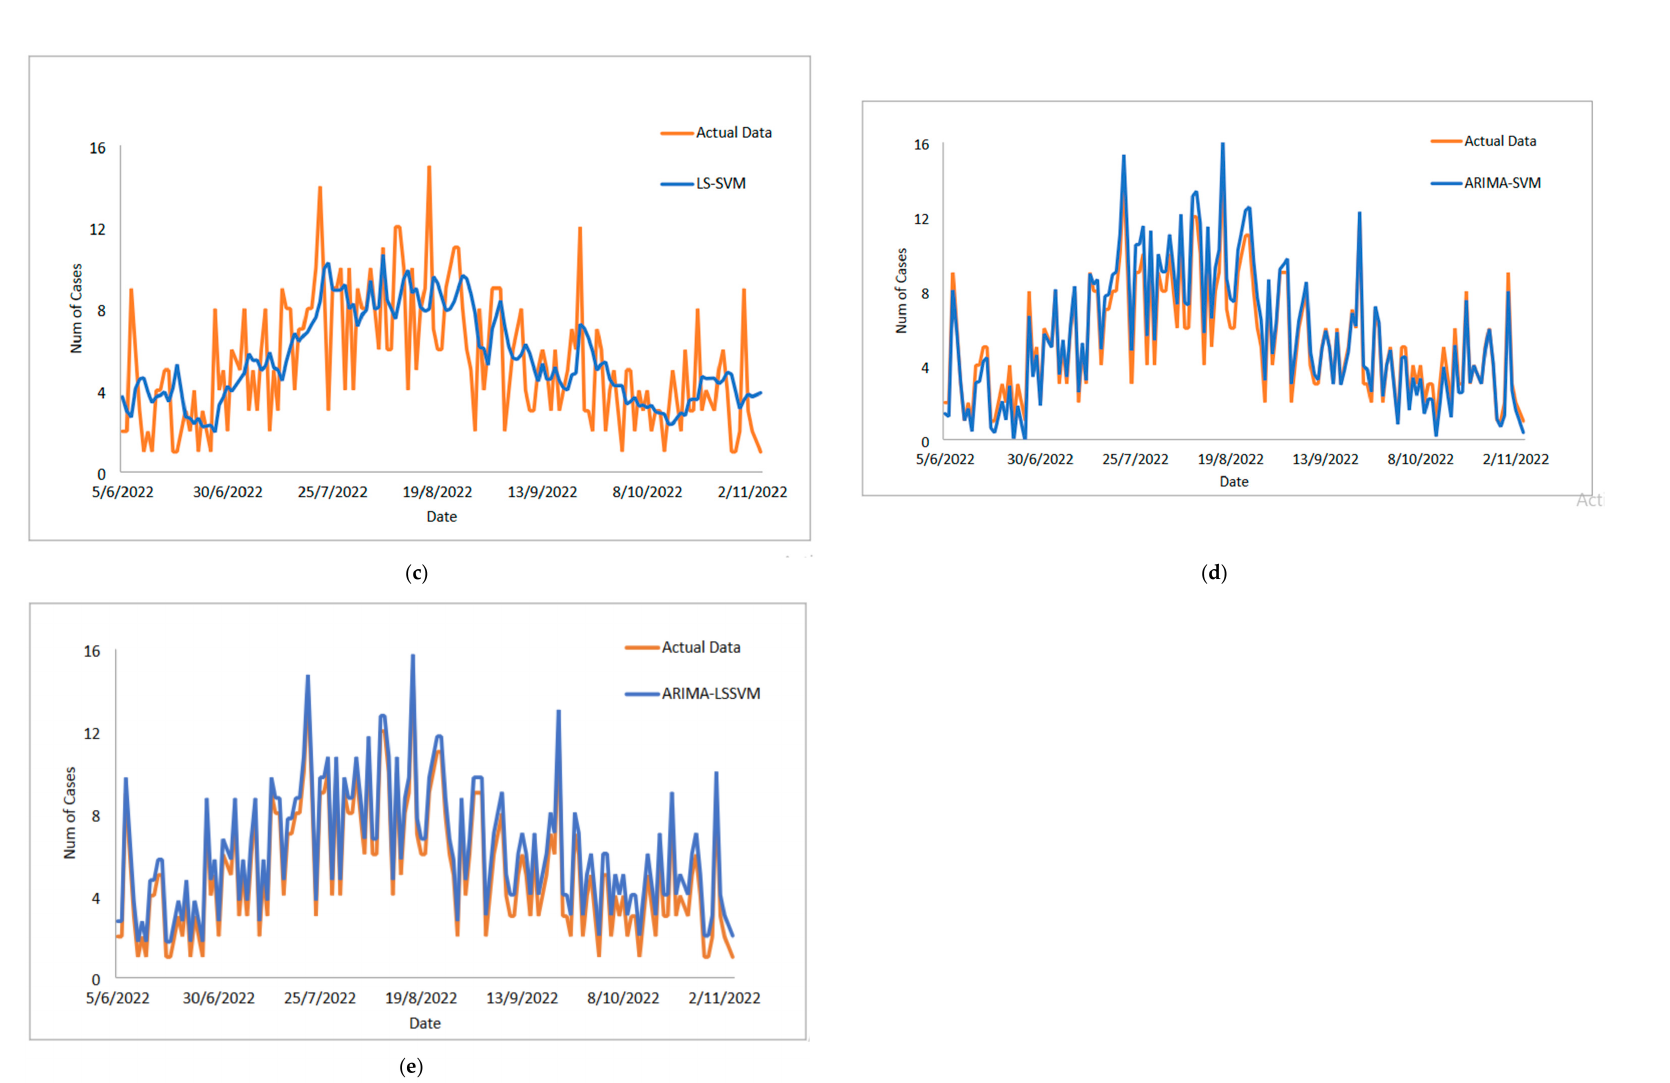
Figure 8. Models’ prediction of daily new death COVID-19 cases dataset (20% test sample): ( a ) actual data vs. ARIMA model, ( b ) actual data vs. SVM model, ( c ) actual data vs. LSSVM models, ( d ) actual data vs. ARIMA–SVM models, ( e ) actual data vs. ARIMA–LSSVM